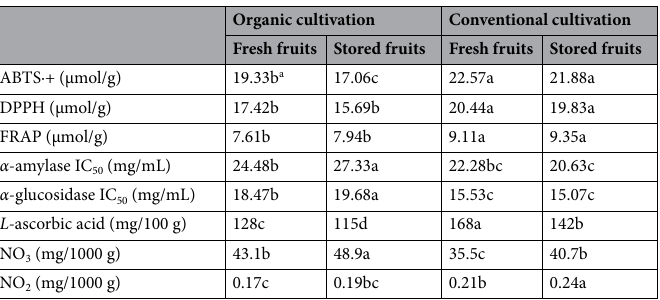
Table 5. Changes in health promoting capacities of highbush blueberry fruit after CA cold storage. a Values followed by the same letter, within the same line, were not significantly different (p < 0.05) according to t-Tukey test.